Question: What style of plot is this figure drawn as?
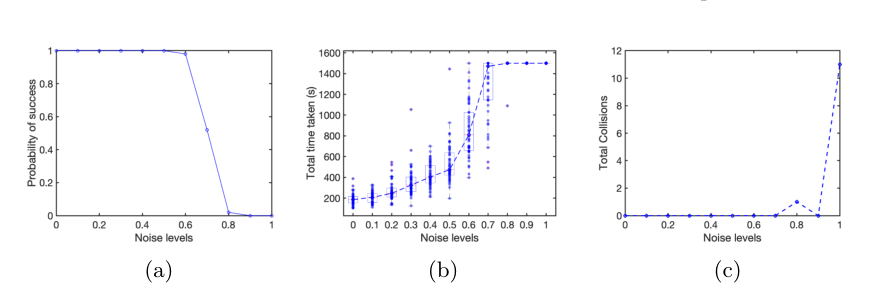
Answer: line